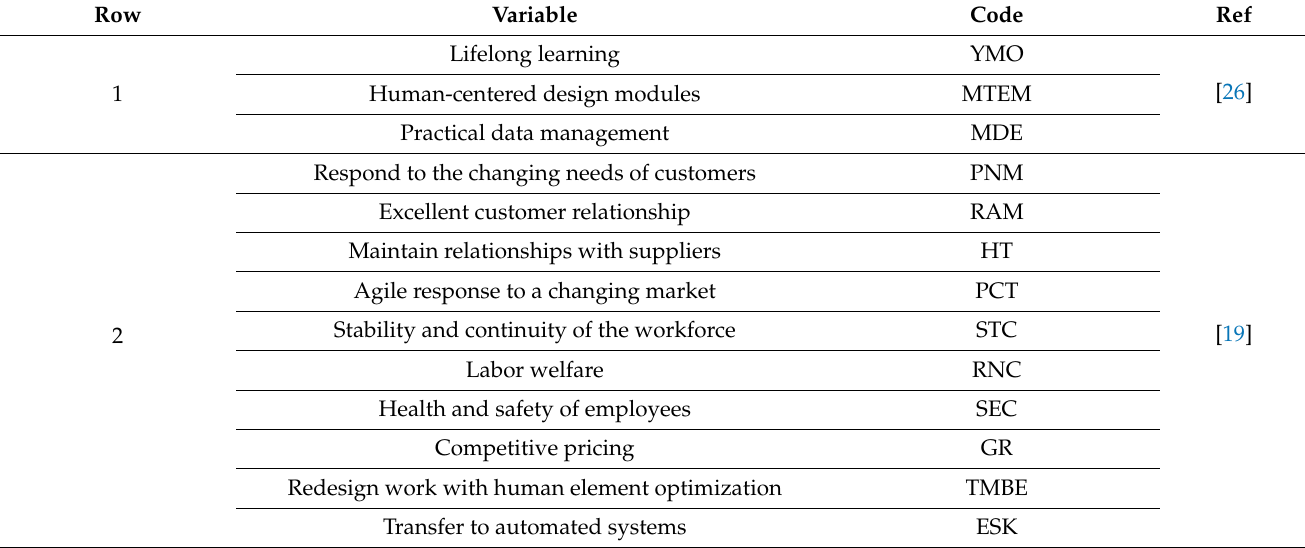
Table 3. Variables extracted from research records (Ref: